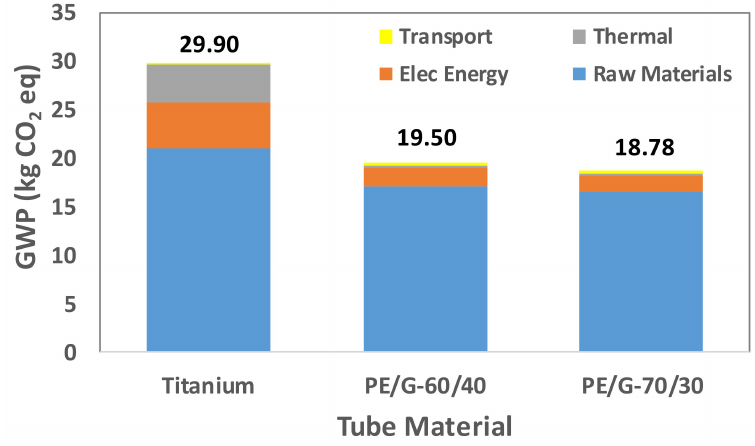
Figure 9. Global warming potential (GWP) for titanium and polymer